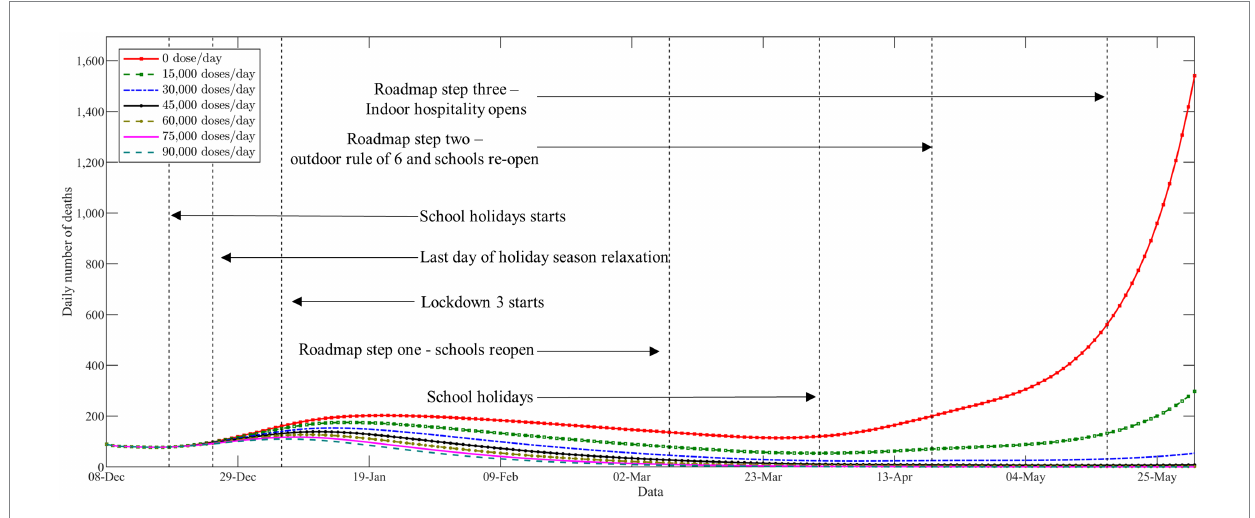
FIGURE 4 The trajectories of the daily number of deaths with respect to different levels of vaccine